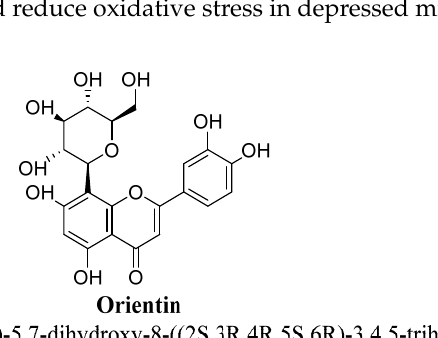
Figure 10. Orientin. Figure 10. Vitexin (C-glycosyl compound and a trihydroxyflavone; Figure 11) is an apigenin flavone glucoside and present in nutraceuticals and foodstuffs. In literature, it has been documented to exert many pharmacological actions such as antitumor, anti-inflamma- tory, peripheral analgesic and antioxidant activities [69–72]. In addition, it has been found to inhibit platelet aggregation, urease, α -glucosidase and adipogenesis [73–76]. Among plants, Vitexin is highly abundant in Passiflora incarnate L. and reported to have significant anxiolytic and anti-depressant activities mediated via interaction with dopaminergic (D1, D2, and D3), serotonergic (5-HT1A) and noradrenergic ( α 2) receptors and also by increas- ing synaptic concentration of neurotransmitters [77]. Figure 11. Vitexin. Structure Activity Relationship (SAR) of Flavones Based on the information available on the activities of various flavones, following SAR appears to be applicable (Figure 12). Figure 12. SAR of Flavones. 1.